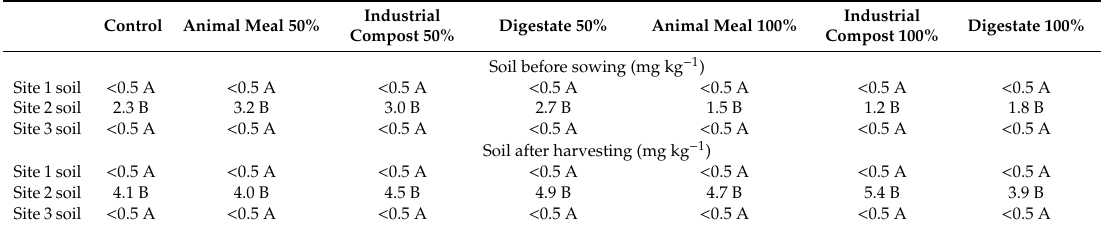
Table 4. E ff ect of soil properties on ammonium nitrogen (N-NH 4 + )